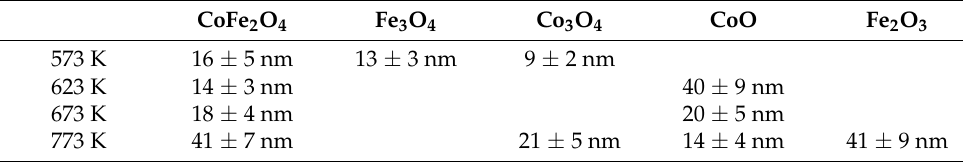
Table 2. Mean particle sizes of the identified phases based on XRD results .